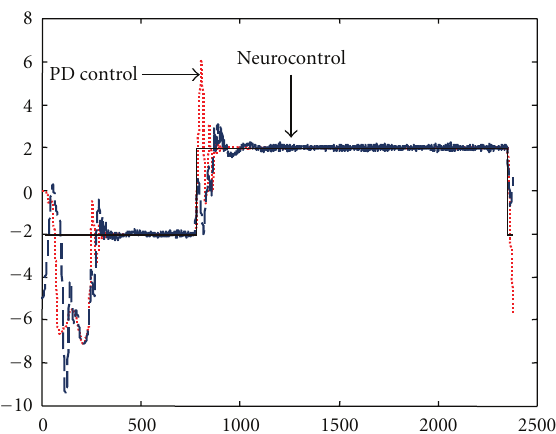
Figure 5: Tracking control of θ 2 (method C).